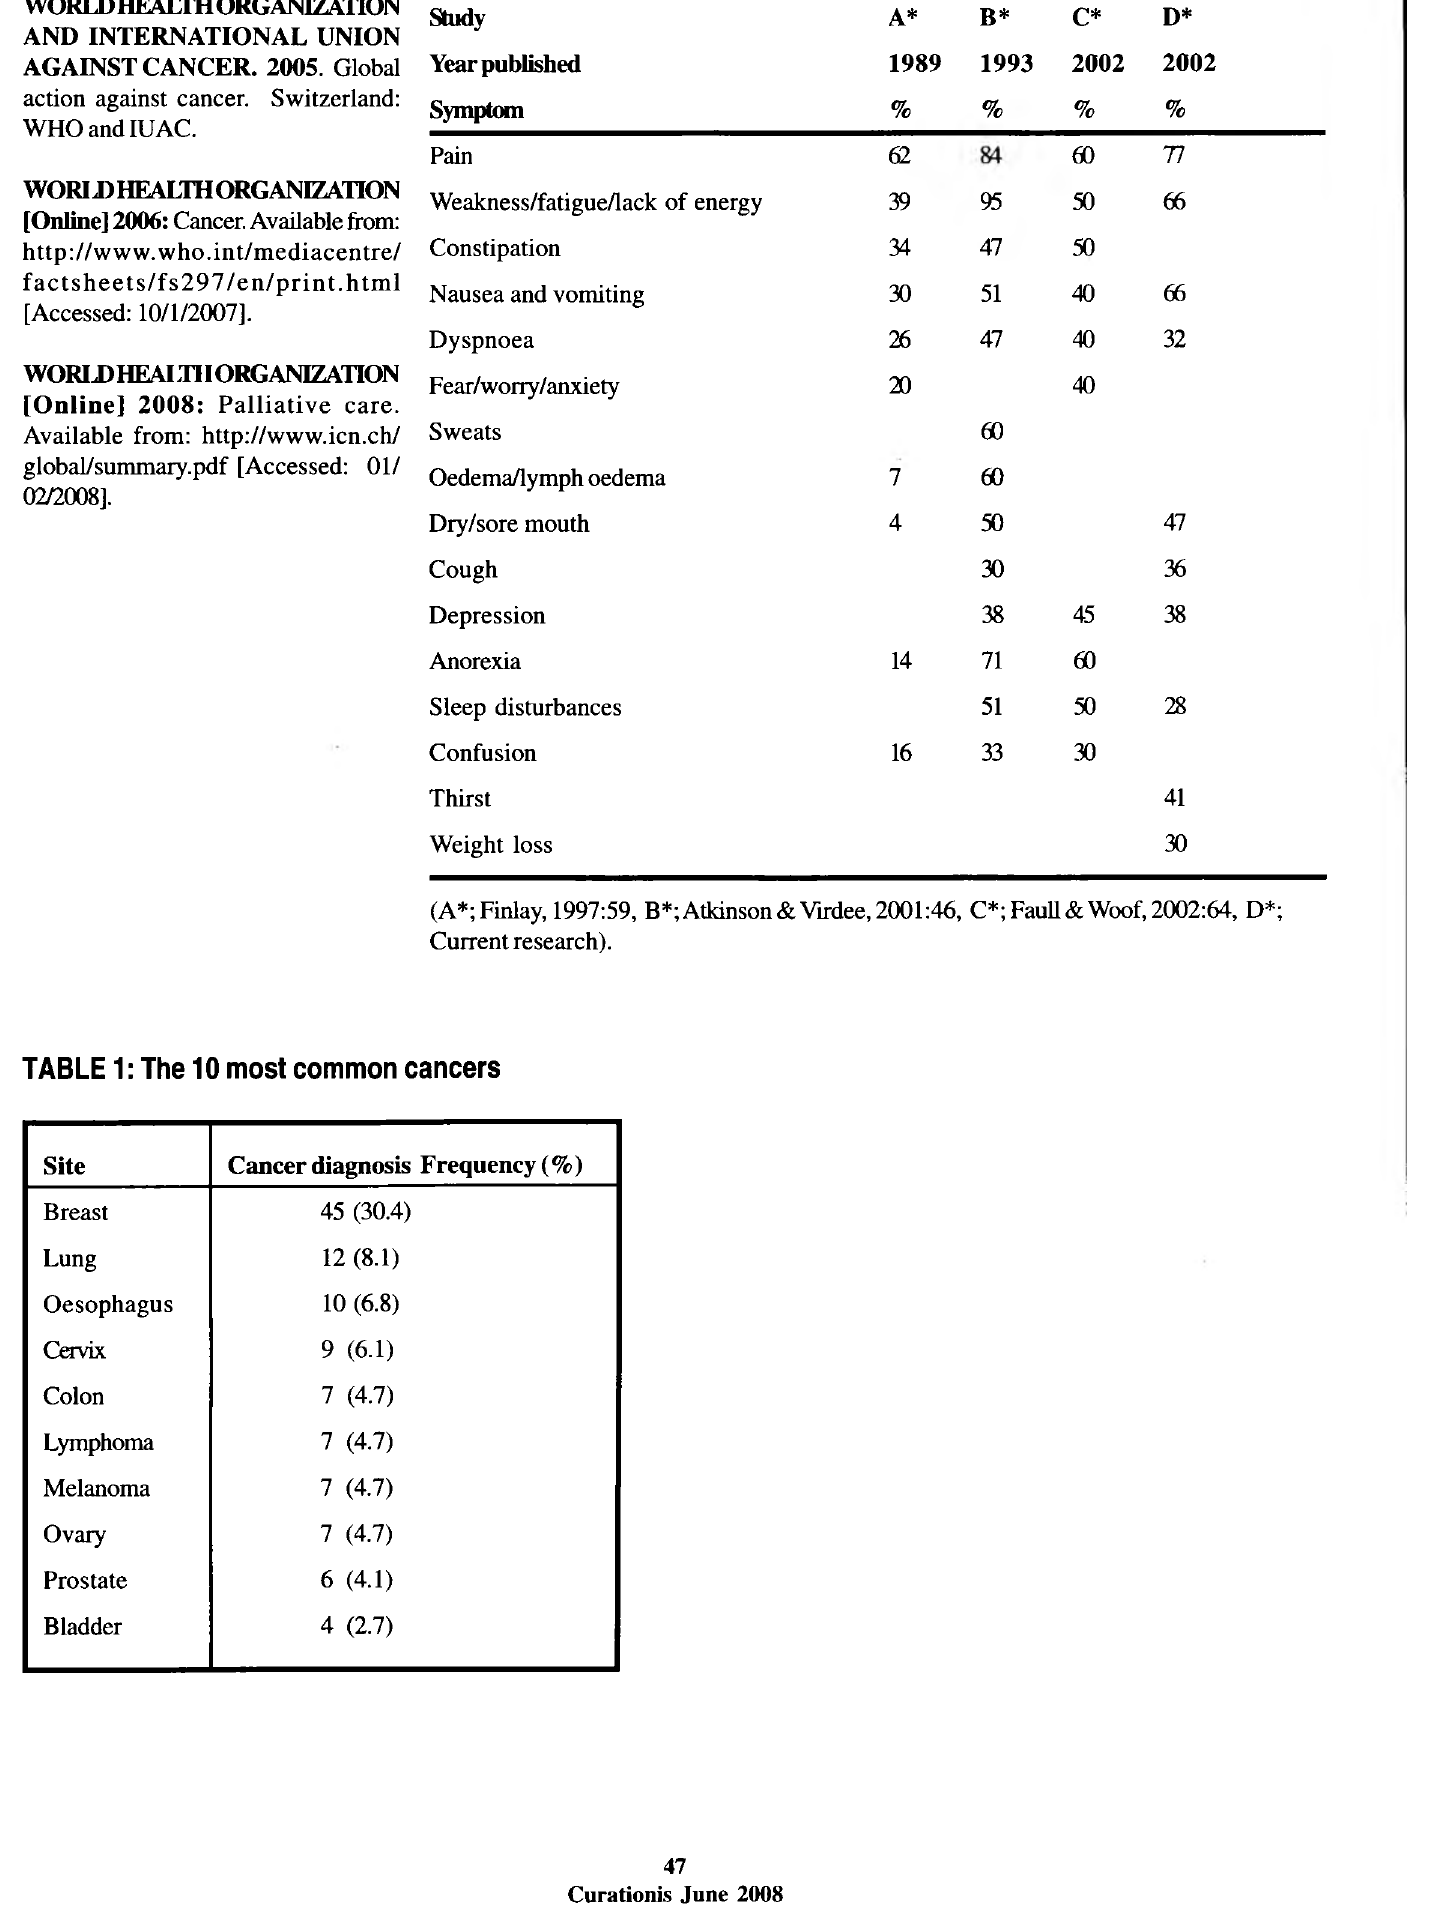
TABLE 2: Percentage of patient symptoms